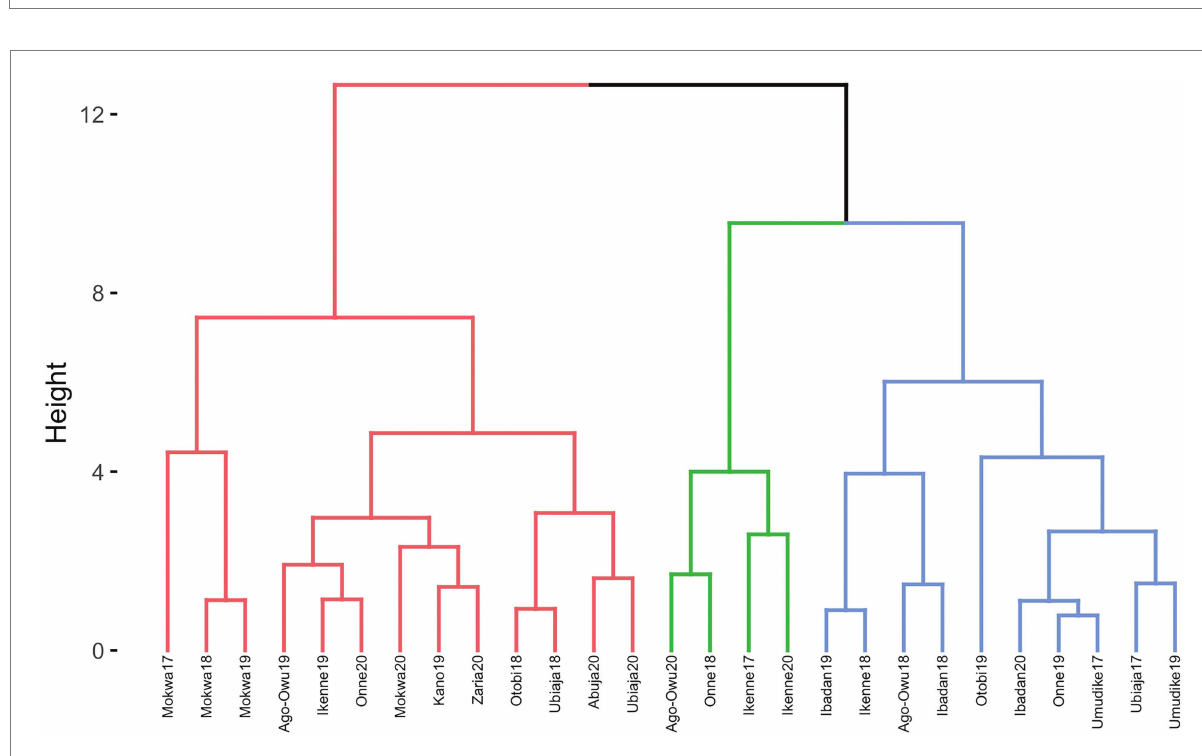
FIGURE 4 Dendrogram of 27 environments based on cassava fresh root yield using rotated factor loadings from FA3 model and Ward’s D2 linkage